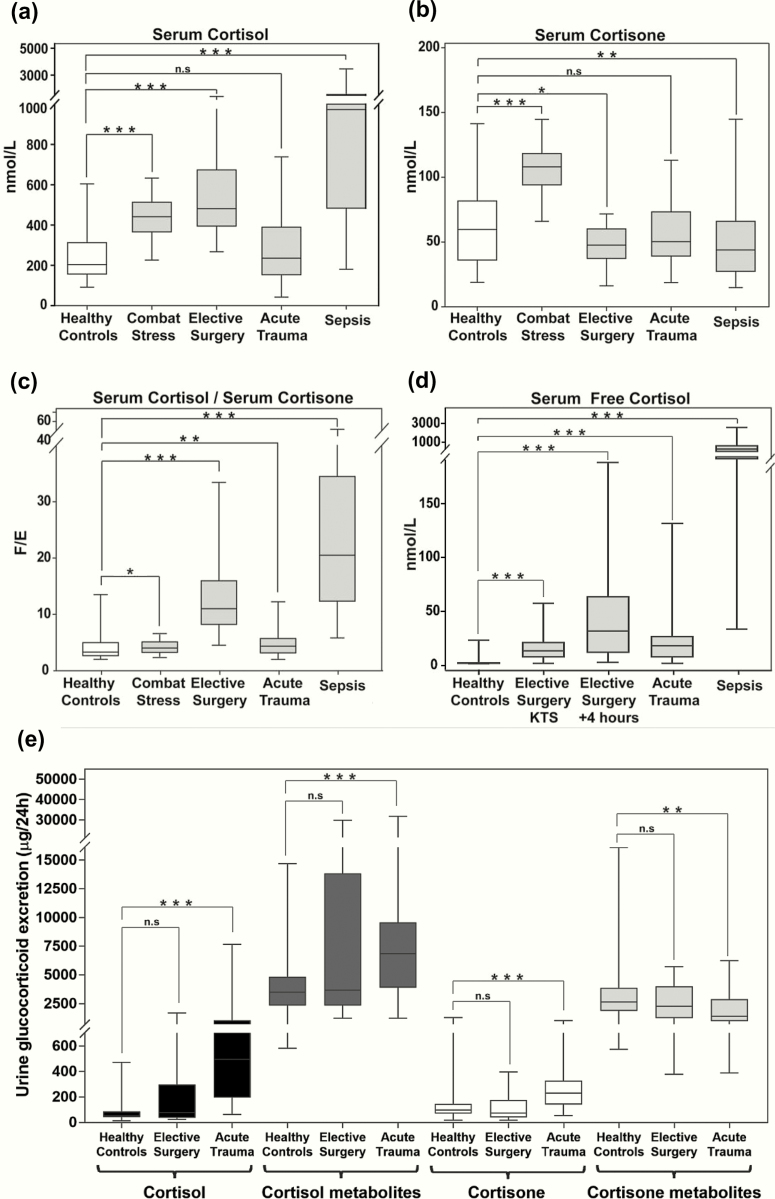
Circulating glucocorticoids during major stress. Serum concentrations of total cortisol (nmol/L) (a), total cortisone (nmol/L) (b), and cortisol (F)/cortisone (E) ratio (c) in healthy controls (N = 122), during combat stress (N = 105), during elective surgery (N = 22), after major trauma (N = 83), and during sepsis (N = 100). In the patients undergoing elective surgery, the maximum serum cortisol levels (and corresponding serum cortisone levels) were used for the calculations. Panel d: reports serum free cortisol concentrations in nmol/L in healthy controls (N = 11), during elective surgery at knife-to-skin (KTS, N = 21), and 4 hours after the start of the operation (N = 21), after major trauma (N = 18), and during sepsis (N = 17). Panel e: reports the 24-hour urinary excretion of cortisol, cortisol metabolites, cortisone, and cortisone metabolites in healthy controls (N = 122), following elective surgery (N = 21) and after major trauma (N = 23). Boxes show median and interquartile range, whiskers are 5th to 95th percentile. Symbols: n.s., P > 0.05; *, P ≤ 0.05; **, P ≤ 0.01; ***, P ≤ 0.001.